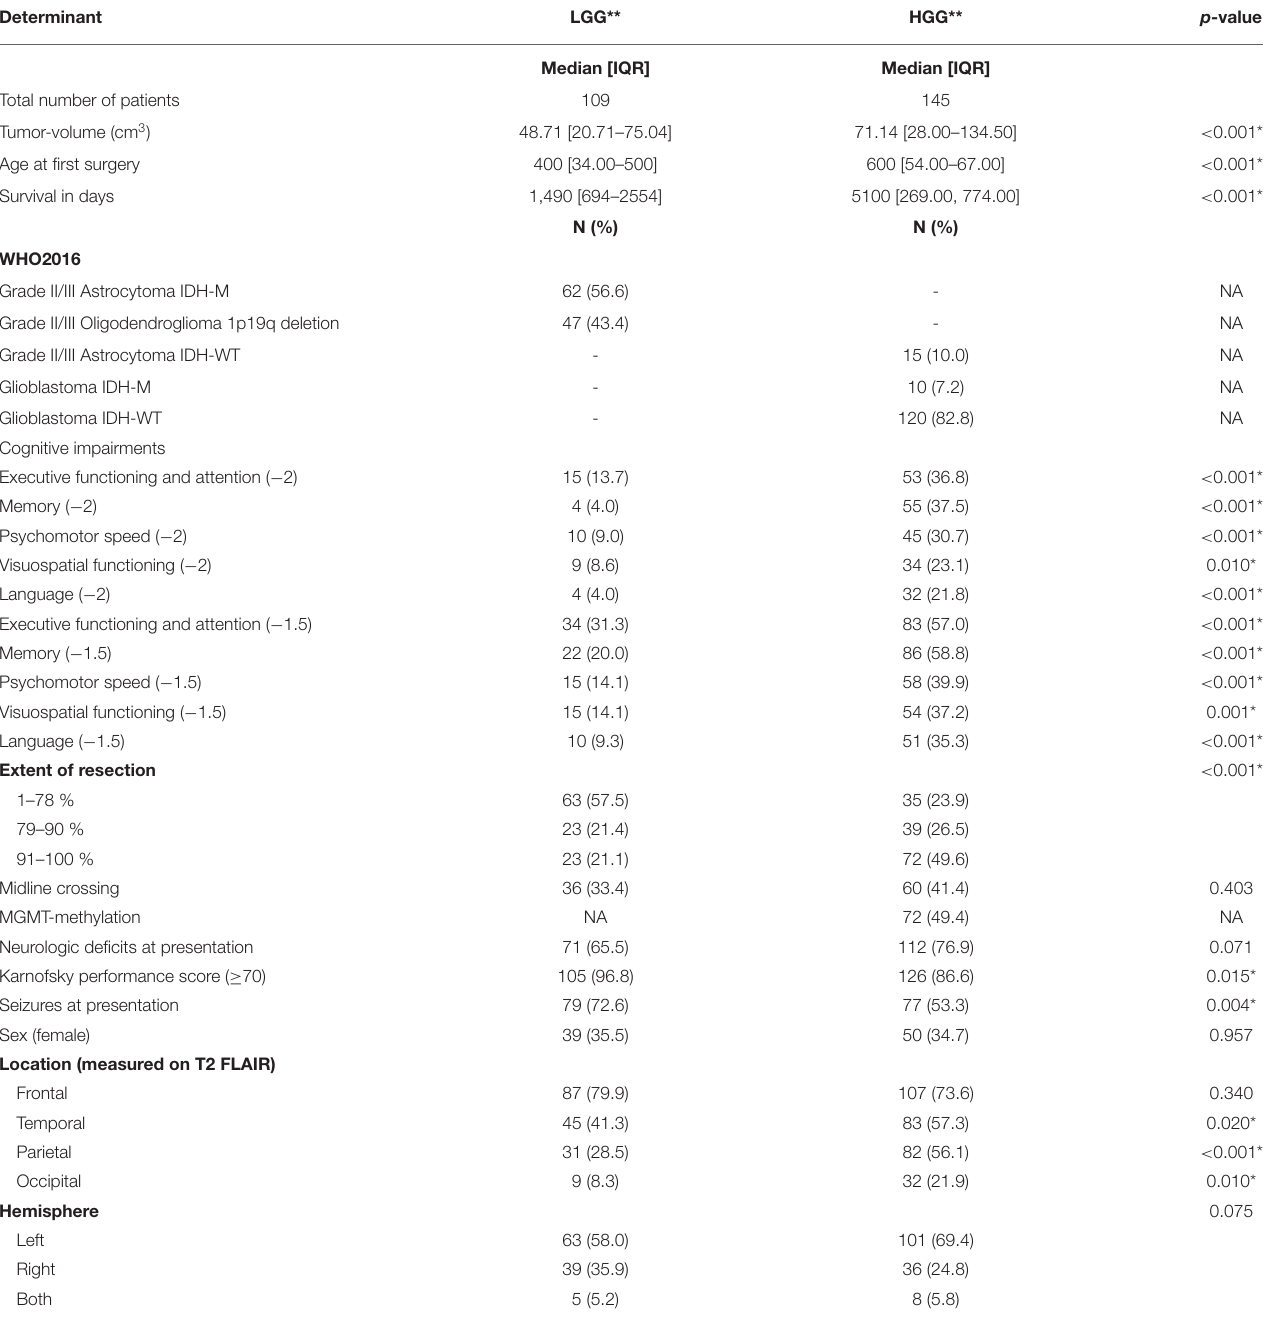
TABLE 2 | Baseline